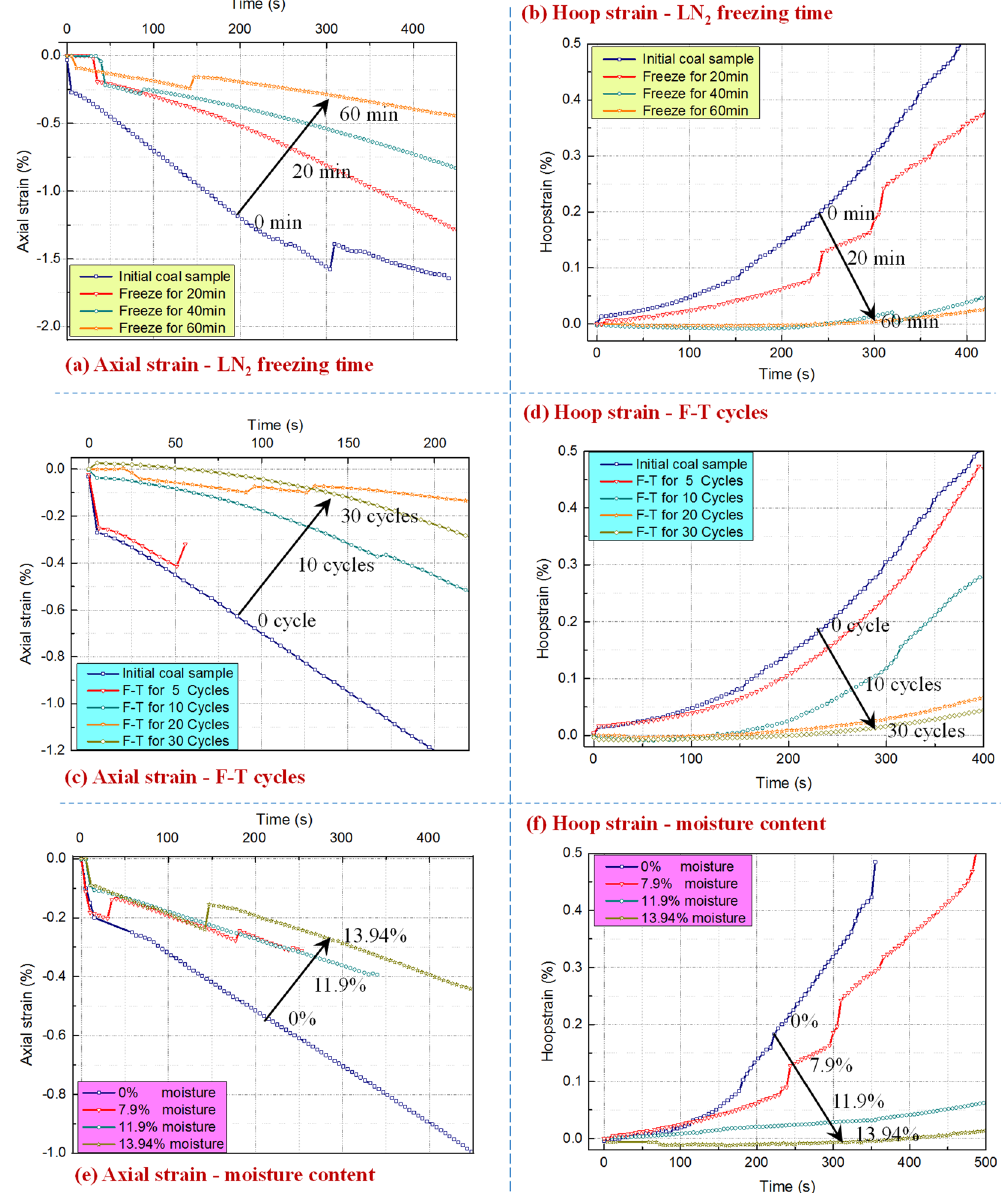
Figure 2. Influence of freeze-thaw variables on strains of the coal masses in the compression process. ( a ), ( c ), and ( e ); axial strains; ( b ), ( d ), and ( f ); hoop